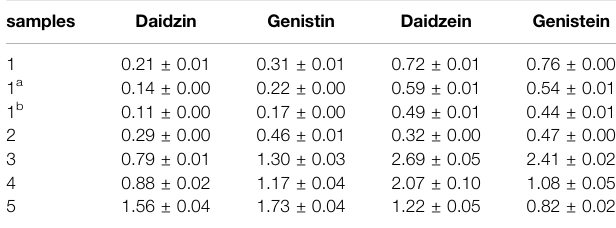
TABLE 3 | Contents offour components in semensojae praeparatum samples by VVA-MSPD, Ultrasound and Heating re fl ux method (mg/g, n (cid:2) 3). samples Daidzin Genistin